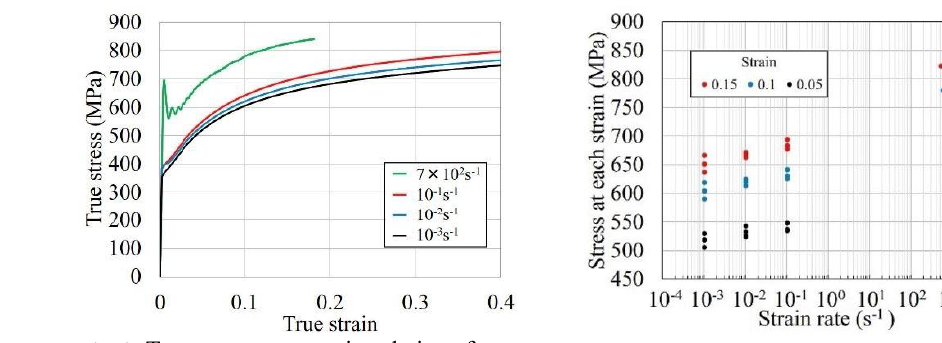
Fig. 3. Stress at each strain-stress rate relations for